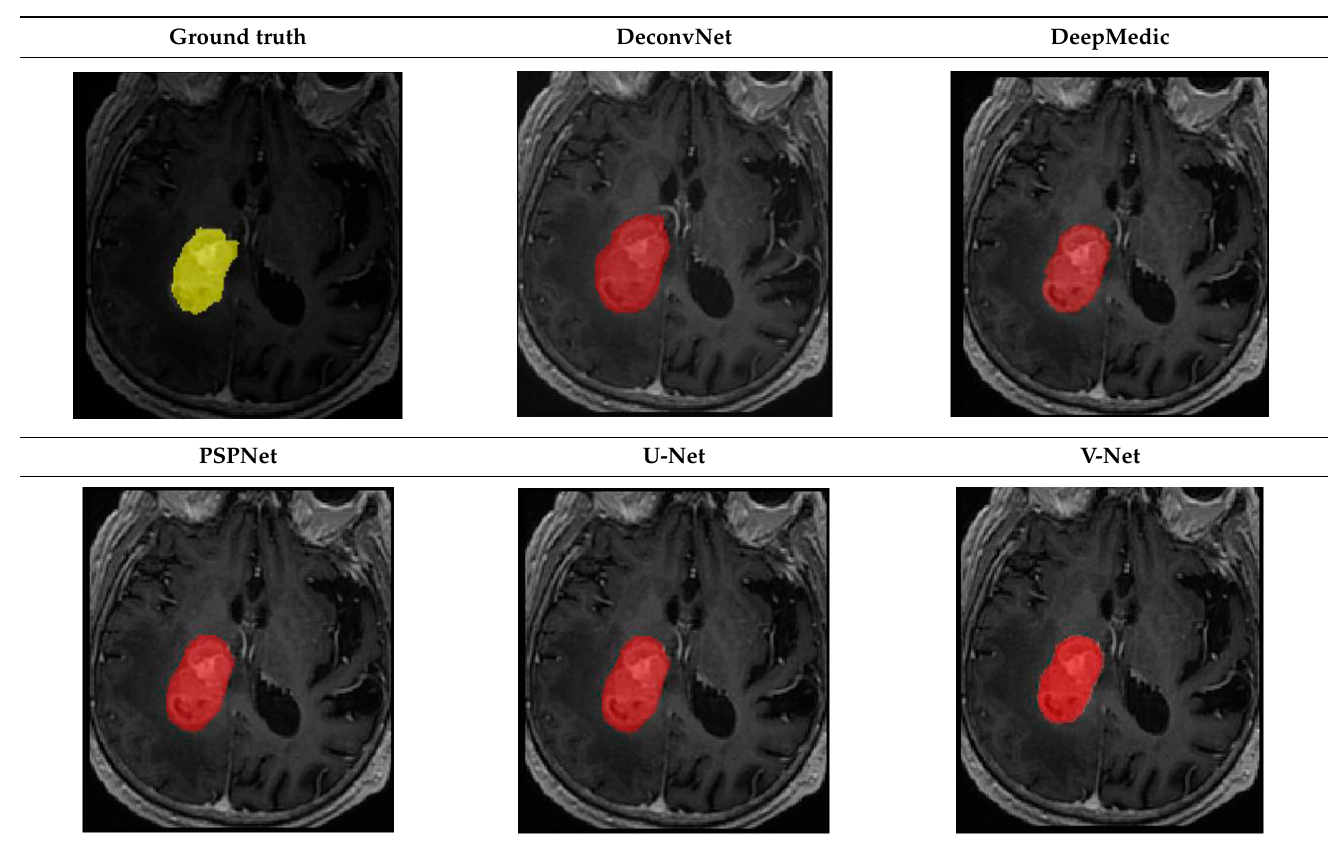
Table 5. Performance of different models on the NTUH dataset.